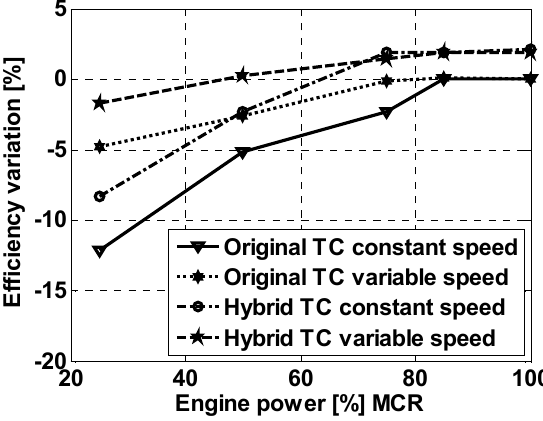
Figure 7. Original and hybrid turbocharger comparison in terms of engine efficiency for different engine loads and constant or variable engine speed.